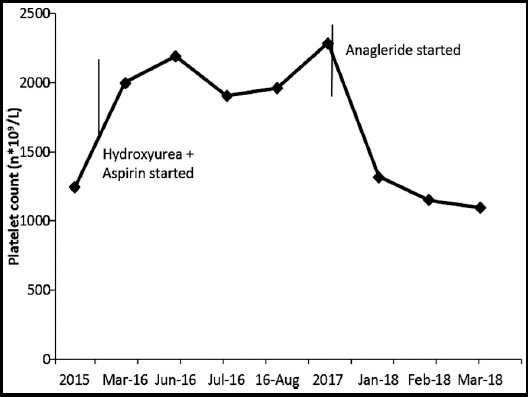
Platelet pattern.